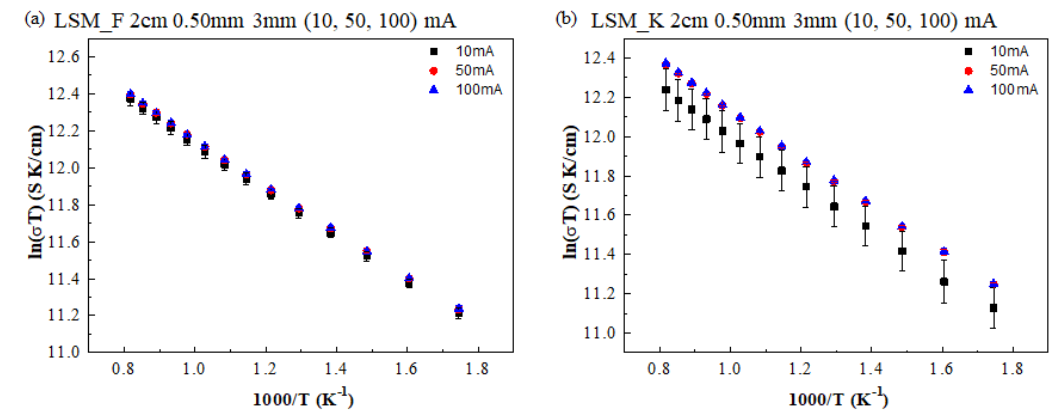
Figure 8. Arrhenius plot of measured electrical conductivity according to applied current: ( a ) LSM-F and ( b ) LSM-K.